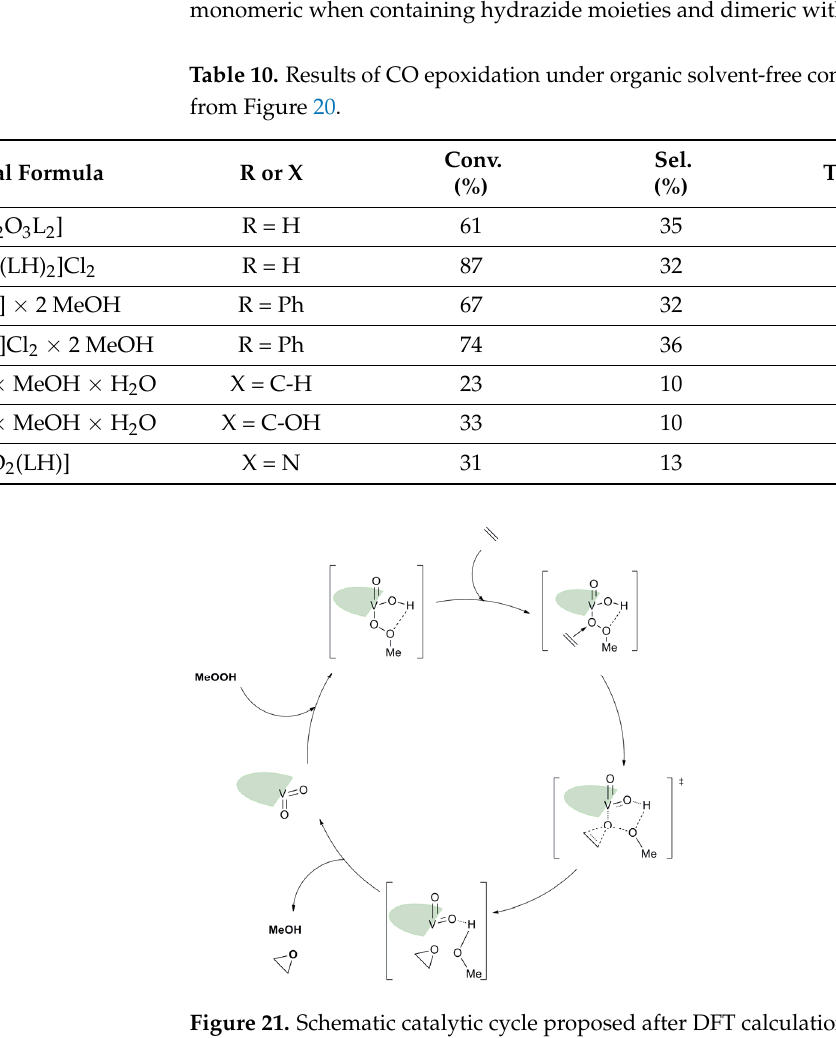
Table 10. Results of CO epoxidation under organic solvent-free conditions with vanadium com- plexes from Figure 20.